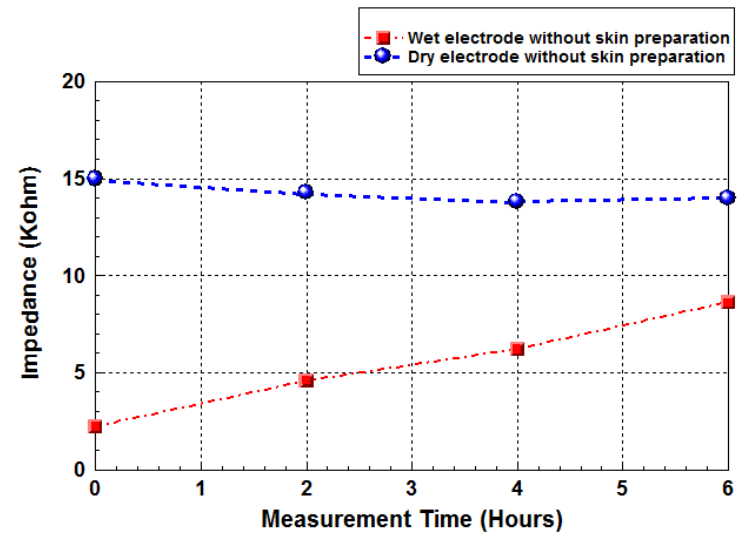
Figure 8. Impedance variations of FPDE and wet electrodes for long-term